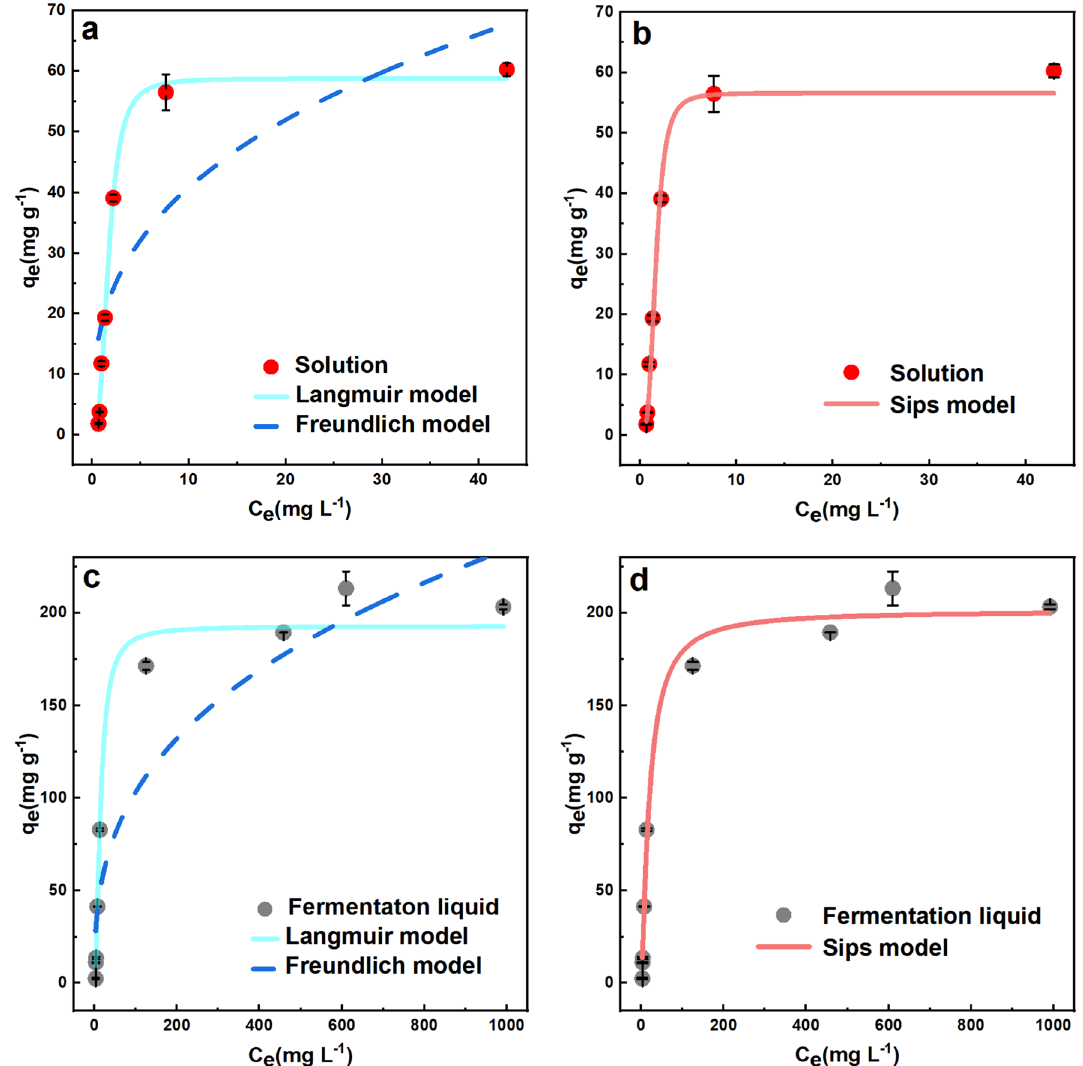
Fig. 5 Adsorption isotherms fitted with Langmuir, Freundlich ( a and c ), and Sips models ( b and d )